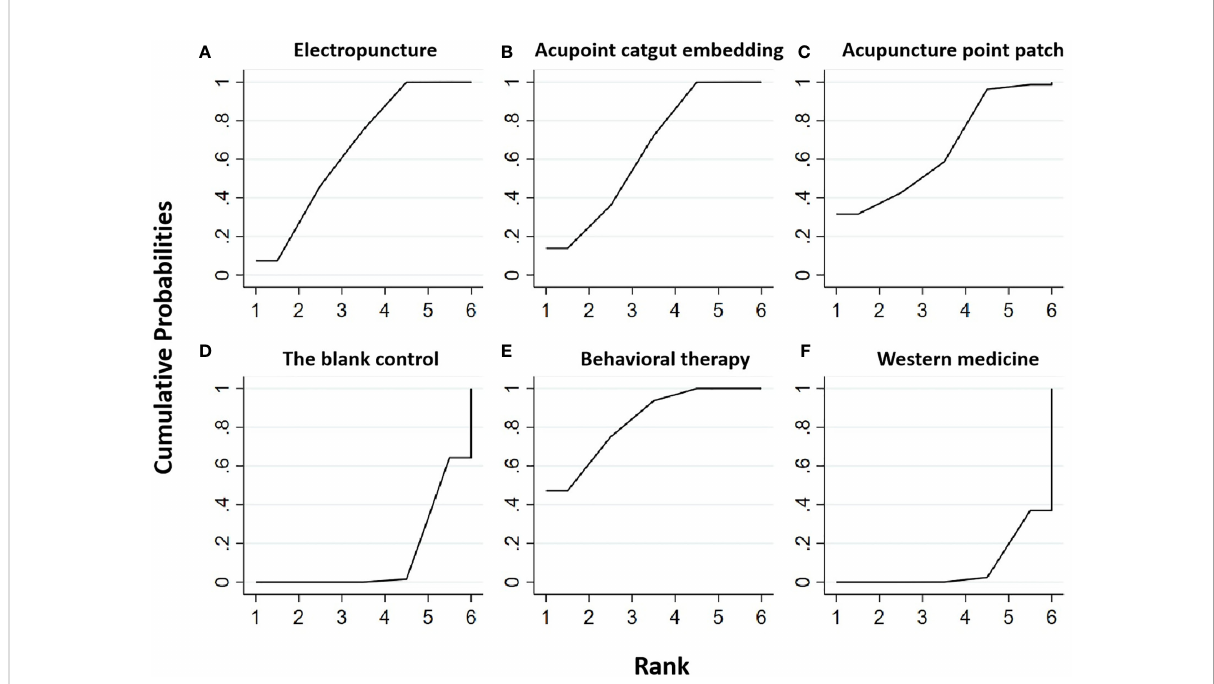
FIGURE 4 Ef fi cacy ranking and cumulative probability graph of fasting serum insulin (FINS) treated by different types of intervention. Comparison of ef fi cacy ranking and cumulative probability of FINS between each kind of intervention. (A) Electropuncture, (B) acupoint catgut embedding, (C) acupuncture point patch, (D) blank control, (E) behavioral therapy, and (F) western